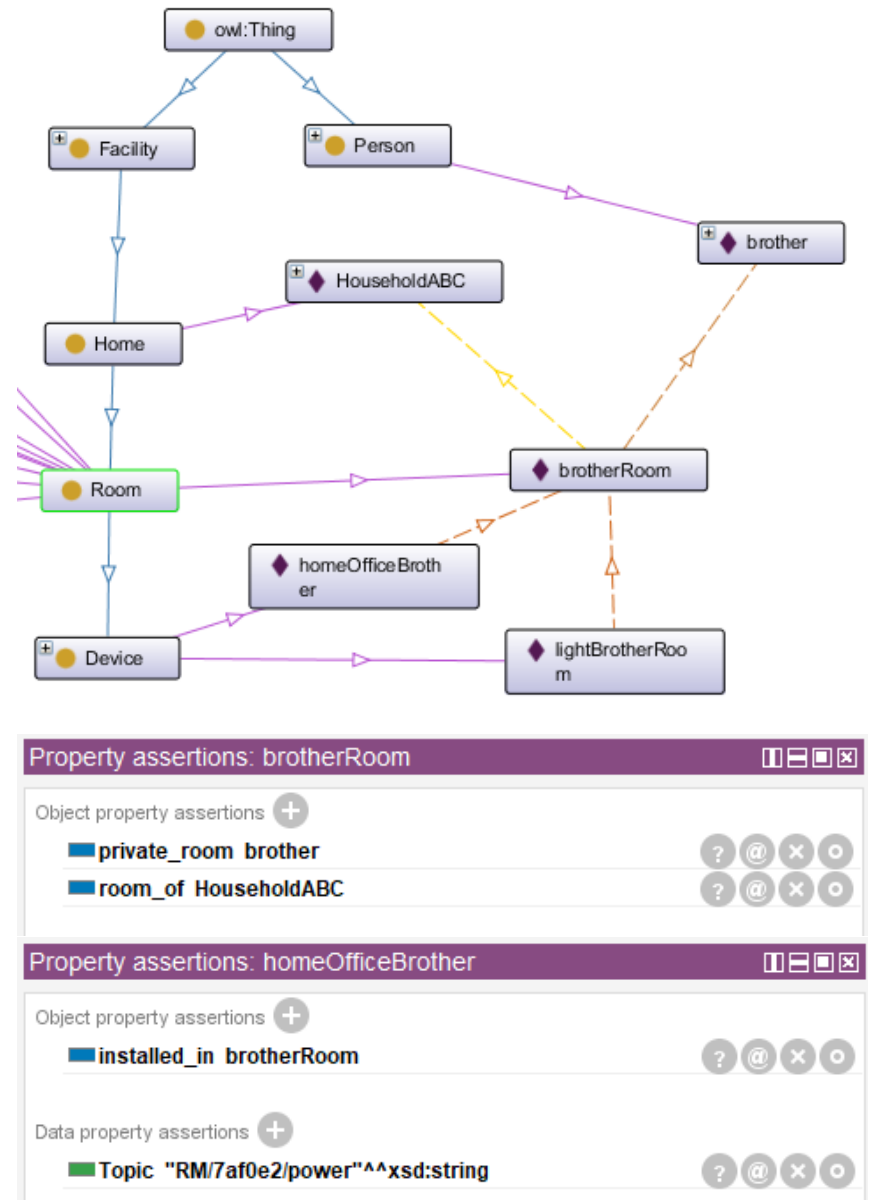
Figure 16. Brother perspective in digital twin smart home